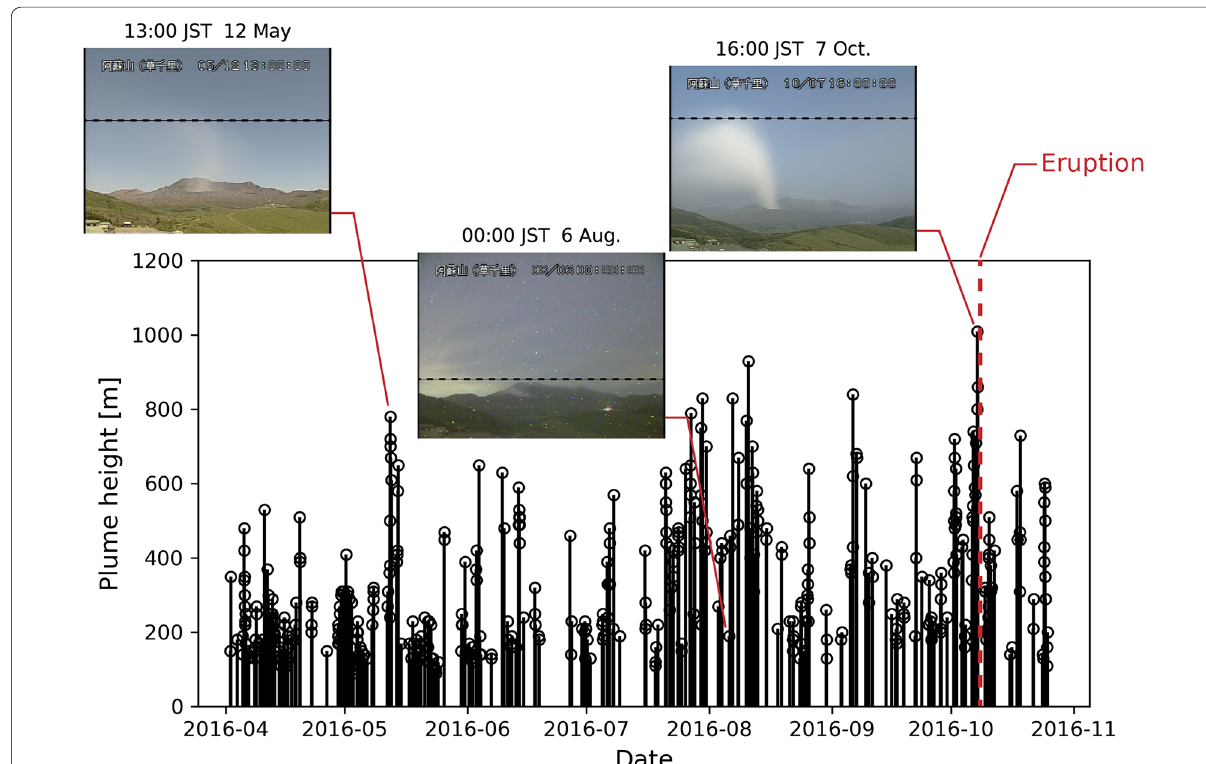
Fig. 2 Time series of the plume height estimated by the monitoring camera and representative examples of the composite camera image. The dotted lines in the images correspond to the top of the